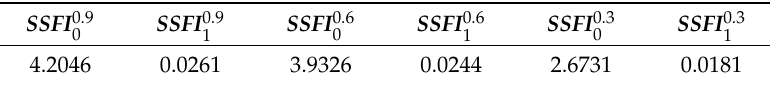
Table 4. SSFI for the network under study (occ. /